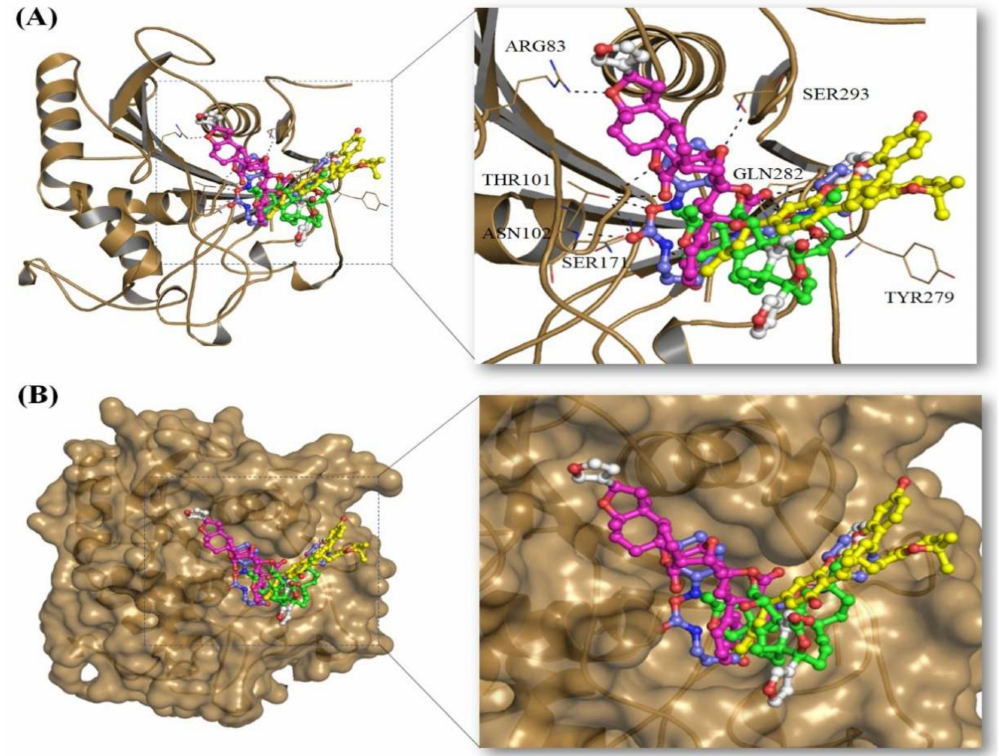
Figure 1. Binding mode of selected compounds: ( A ) Cartoon representation of Mrlip1 complexed with all four compounds; ( B ) surface representation of Mrlip1 complexed with all four compounds (compounds shown in ball and stick models; RHC80267 (Blue element), ZINC85530919 (Yellow element), ZINC85530320 (Green element) and ZINC95914464 (Magenta